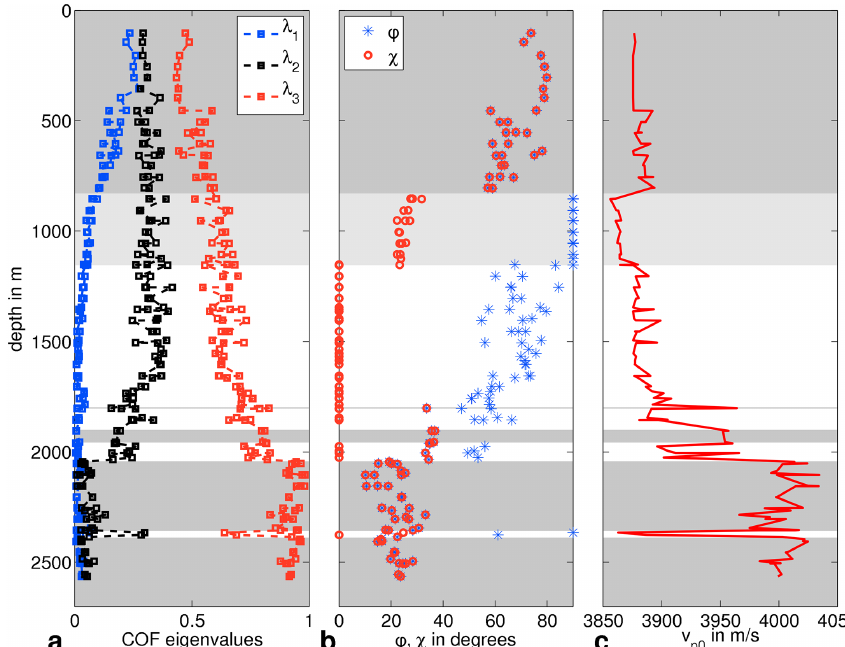
Figure 2. (a) COF eigenvalues derived from the orientation tensor measured on thin sections of the ice core EDML. (b) Opening angles derived from the eigenvalues in (a) . Dark grey regions with ϕ = χ contain cone fabrics, light-grey regions with ϕ = 90 ◦ contain thick girdle fabrics and white regions with χ = 0 ◦ contain partial girdle fabric. (c) Zero-offset P-wave velocity v p0 calculated from the elasticity tensors derived from the opening angles in (b)